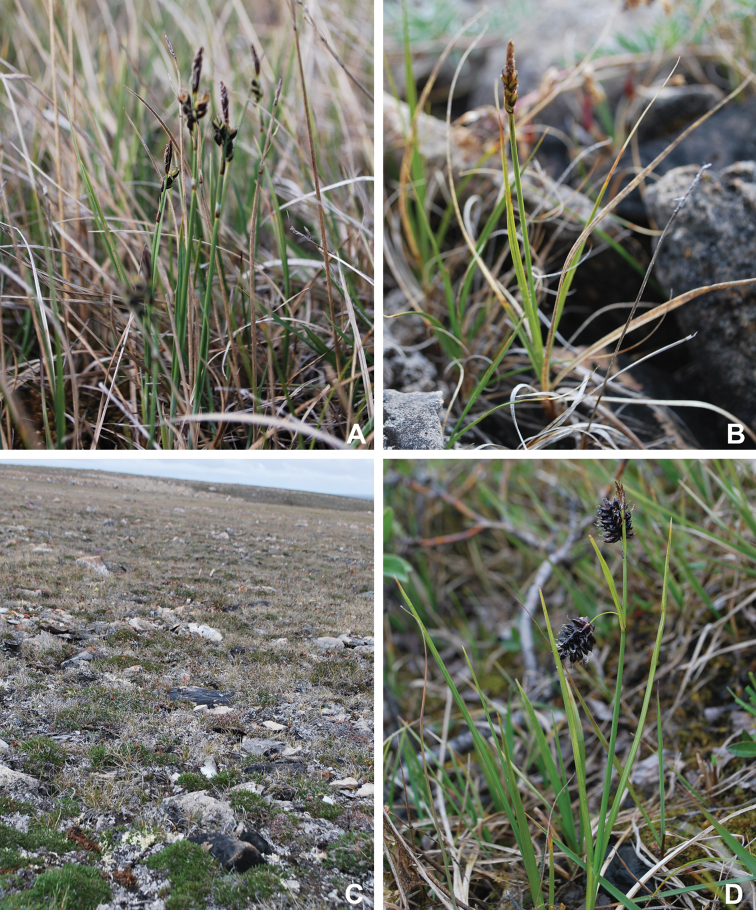
ACarex
rariflora habit BCarex
rupestris habit CCarex
rupestris habitat DCarex
saxatilis habit. Photos by B.A. Bennett.